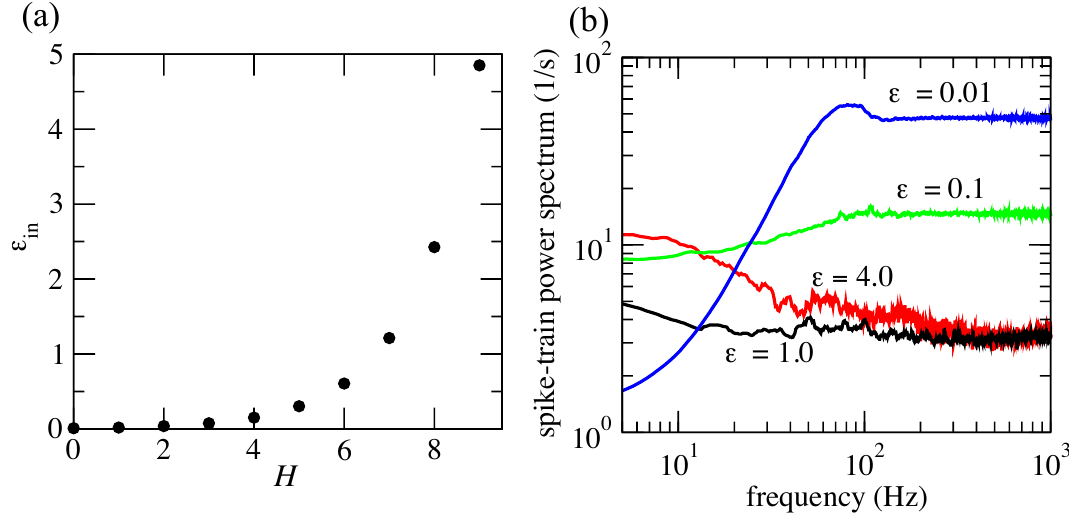
Figure 6. Relation of connectivity and slow fluctuations. ( a ) Values of connectivity inside a module ( (cid:101) in ) as H increases (cf. Equations (14)–(18)). ( b ) Spike-train power spectra extracted for a small network with N = 2 14 and H = 0 for different values of (cid:101)